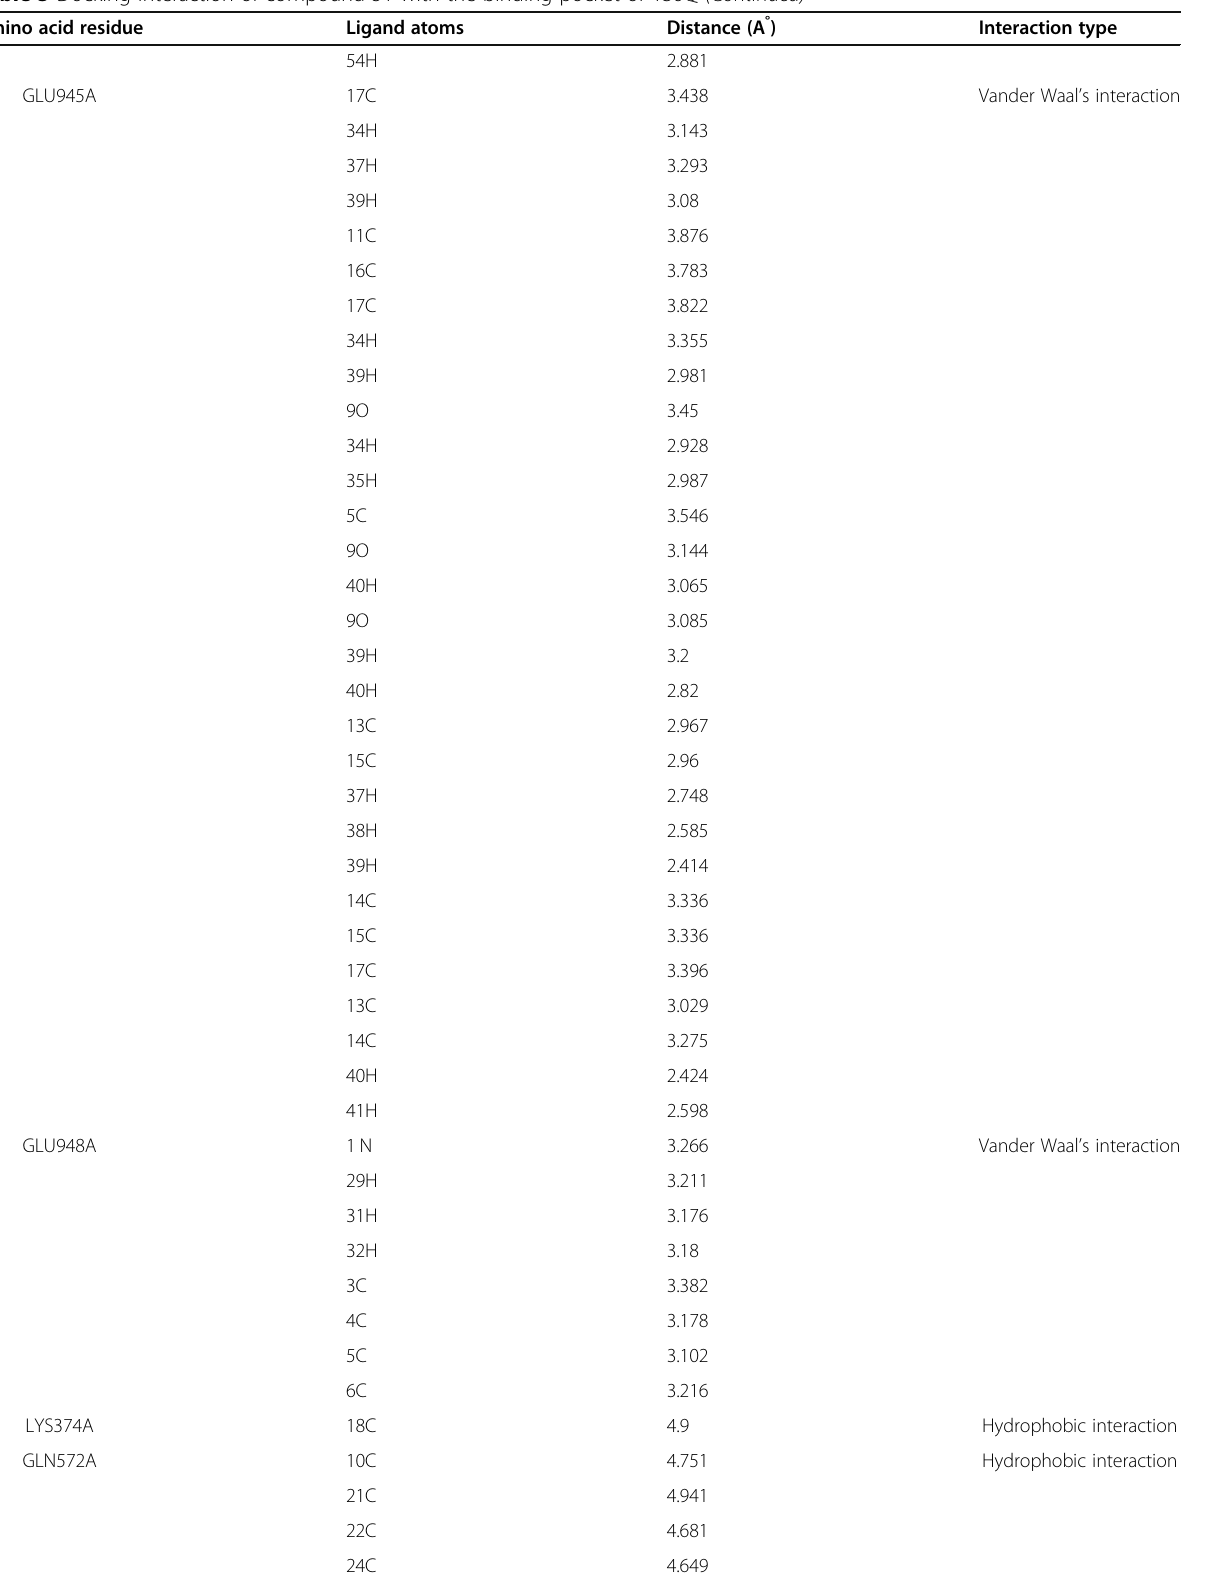
Table 5 Docking interaction of compound 51 with the binding pocket of 1S6Q (Continued) Amino acid